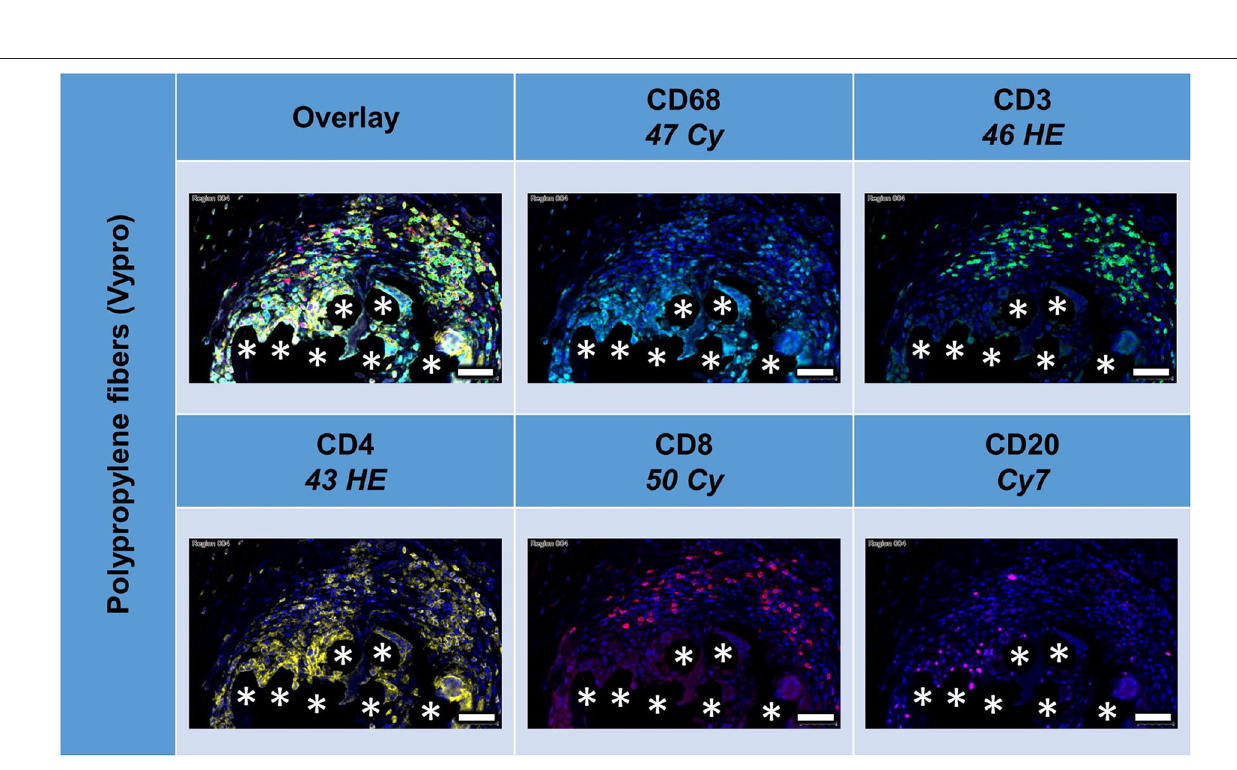
FIGURE 4 | Example of mesh-tissue section stained with lymphocyte panel. Labeling for nuclei with DAPI (blue), macrophages with CD68 (turquoise), T-lymphocytes with CD3 (green), T-helper cells with CD4 (yellow), cytotoxic T cells with CD8 (red), and B-lymphocytes with CD20 (magenta). Asterisks mark fiber locations, scale bars = 50 µ